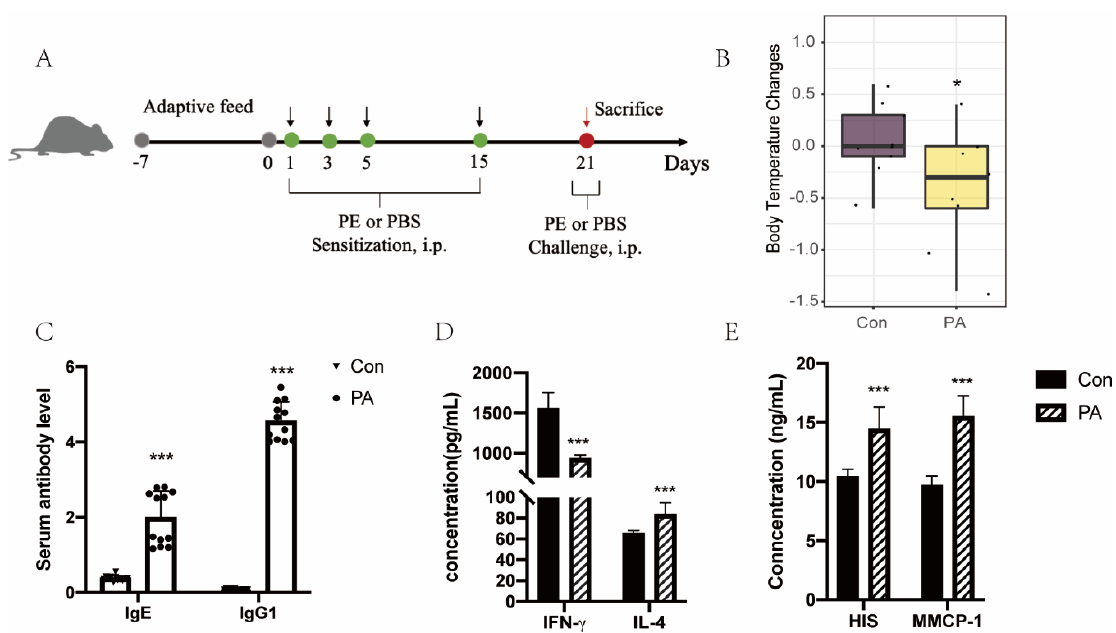
Figure 1. Peanut induced the Th2-type hypersensitivity response. ( A ) Schematic drawing for the Brown Norway rat systematical peanut allergy protocols applied in this study (N Con = 18, N PA = 23). ( B ) The body temperature changes after challenge on Day 21. ( C ) The secretion of peanut-specific antibody IgE and IgG1 between Con and PA groups. ( D ) The level of Th1 cytokine IFN- γ and Th2 cytokine IL-4. ( E ) Histamine and MMCP-1 release levels in PA individuals and their controls. Con: control group, PA: peanut allergy group. * p < 0.05, *** p < 0.001 (compared to the control group).